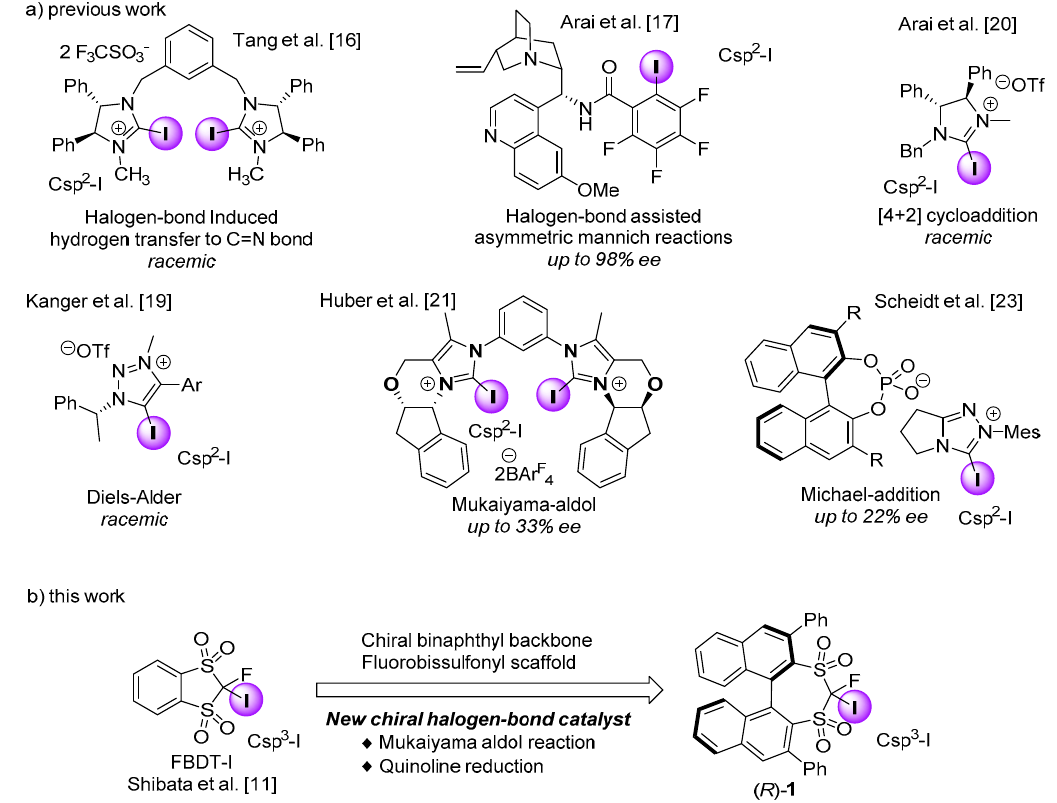
Figure 1. The use of chiral halogen-bond donors as organo-catalysts: ( a ) previous work, ( b ) this work.